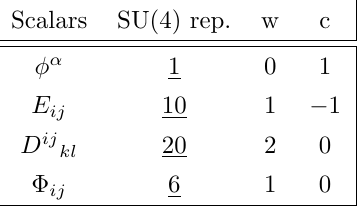
Table 1 . Scalars of the Weyl multiplet ( (cid:30); E; D ) and the Yang-Mills multiplet ((cid:8)), together with their SU(4) assignments, Weyl ( w ) and chiral ( c )